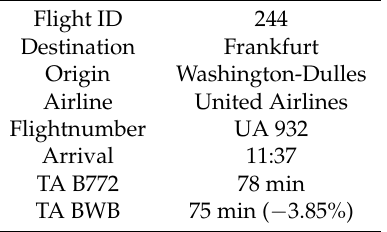
Table 5. Turnaround of B772 and BWB.